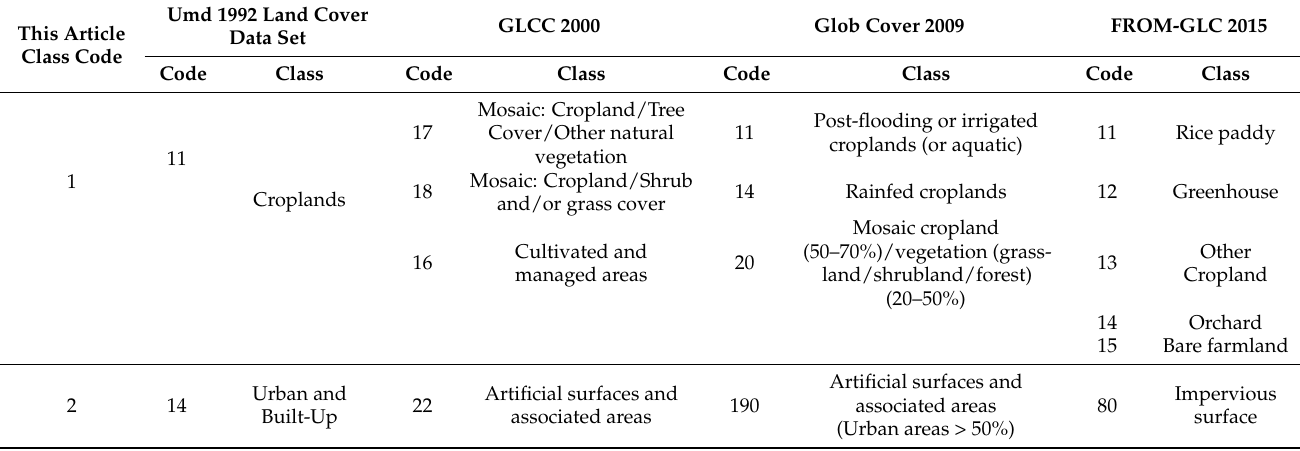
Table 2. Comparison of land use classification